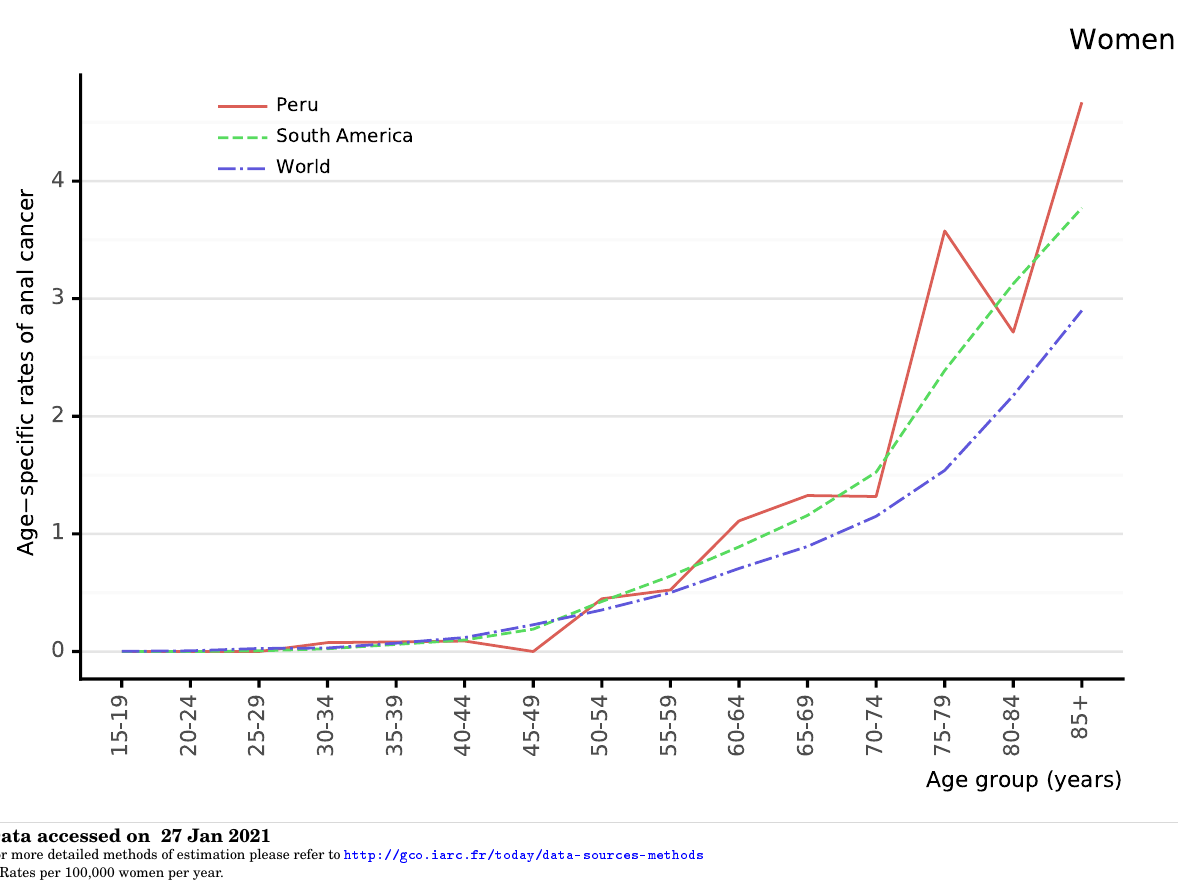
Figure 112: Comparison of age-specific anal cancer mortality rates among women by age in Peru, within the region, and the rest of